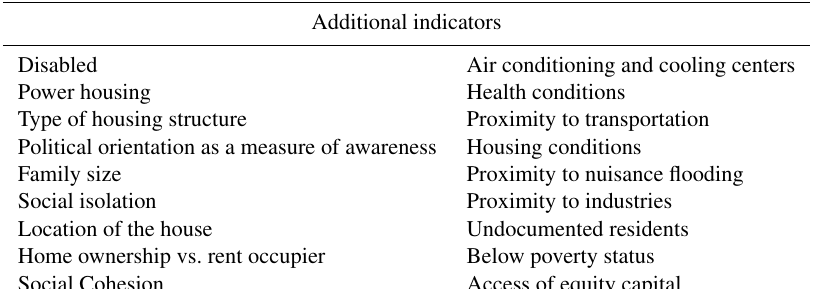
Table 5. Indicators that have been suggested by the survey and that could be further integrated in this type of assessment depending on the availability of the data.